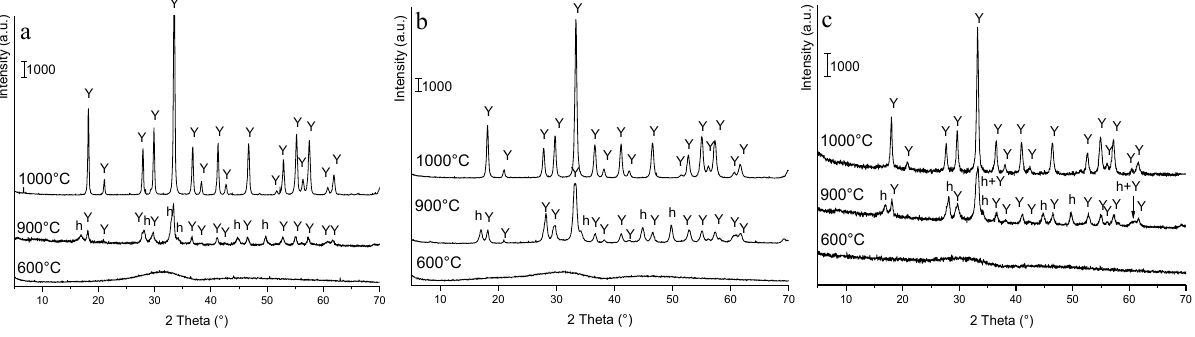
Figure 3. XRD patterns of ( a ) YAG cl -AA, ( b ) YAG cl -AHC0.5 and ( c ) YAG n -AHC0.5 calcined at 600 °C/1 h, 900 °C/30 min and 1000 °C/30 min. (In the figures: Y = YAG; h = hexagonal-YAlO 3